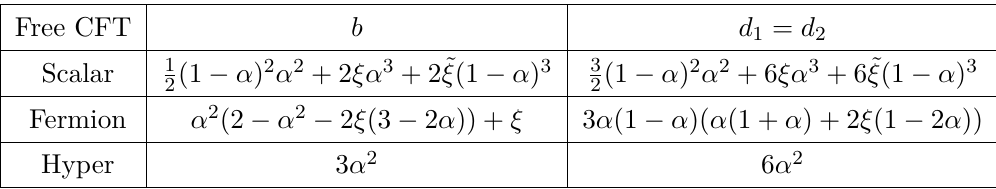
Table 1. Central charges of monodromy defects in d = 4 with parameter α of free scalars, free fermions, and free N = 2 hypermultiplets. From eqs. (2.6), (2.8), and (2.9), d 1 = d 2 is expected for monodromy defects and is verified explicitly in the calculations below. The parameters ξ and ˜ ξ are discussed in detail in section 3 and take values in the range ξ, ˜ ξ ∈ [0 , 1]